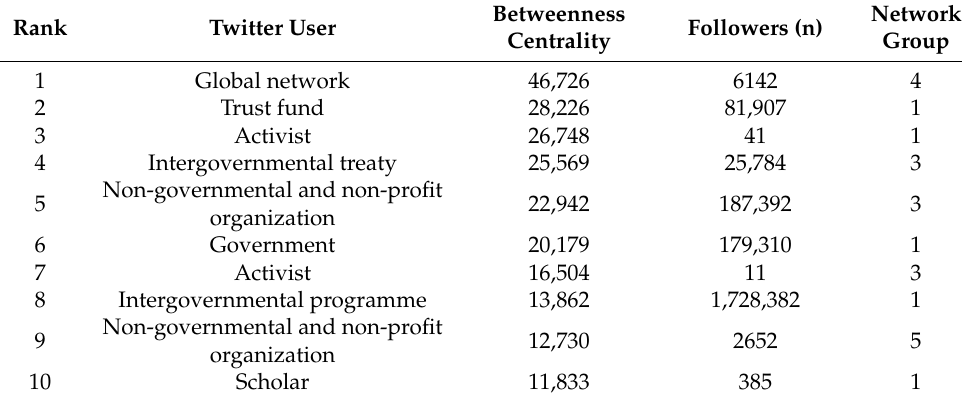
Table 3. Influential users ranked by their betweenness centrality score (3 February 2022).